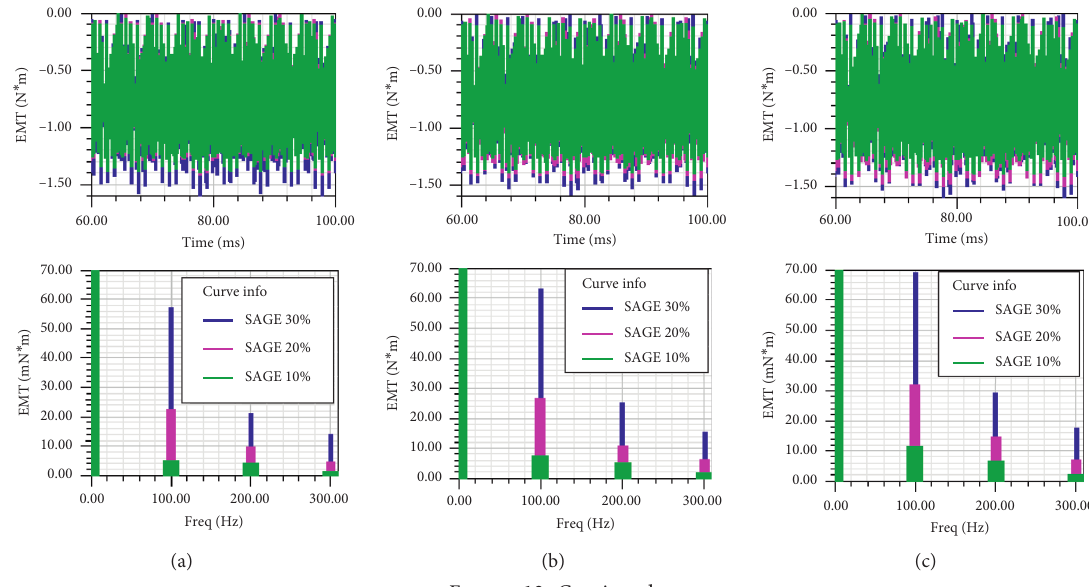
Figure 11: FEA and experiment comparison in SISC cases: (a) 2nd harmonic, (b) 4th harmonic, and (c) 6th harmonic.